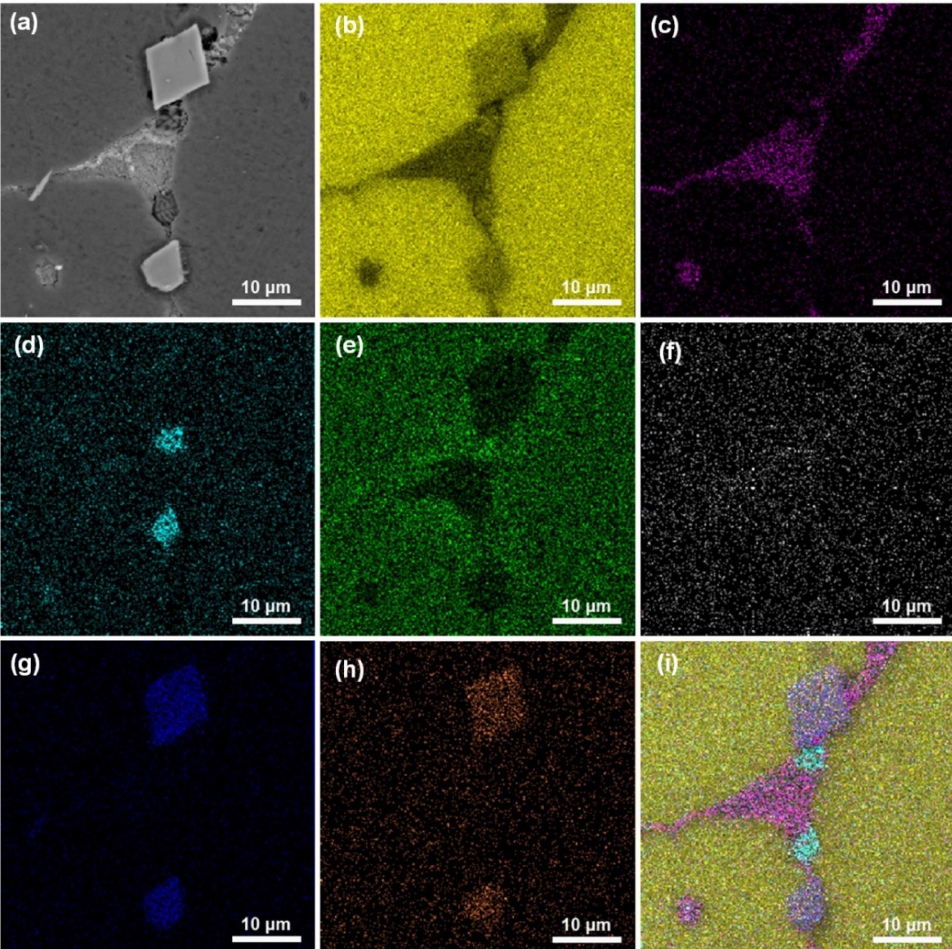
Figure 8. ( a ) SEM image; ( b ) Al; ( c ) Cu; ( d ) Si; ( e ) Mg; ( f ) Zn; ( g ) Fe; ( h ) Mn; ( i ) Al Fe Si Mn Cu X-ray image analysis of a compressed sample isothermally heat treated at 600 ˝ C for 25